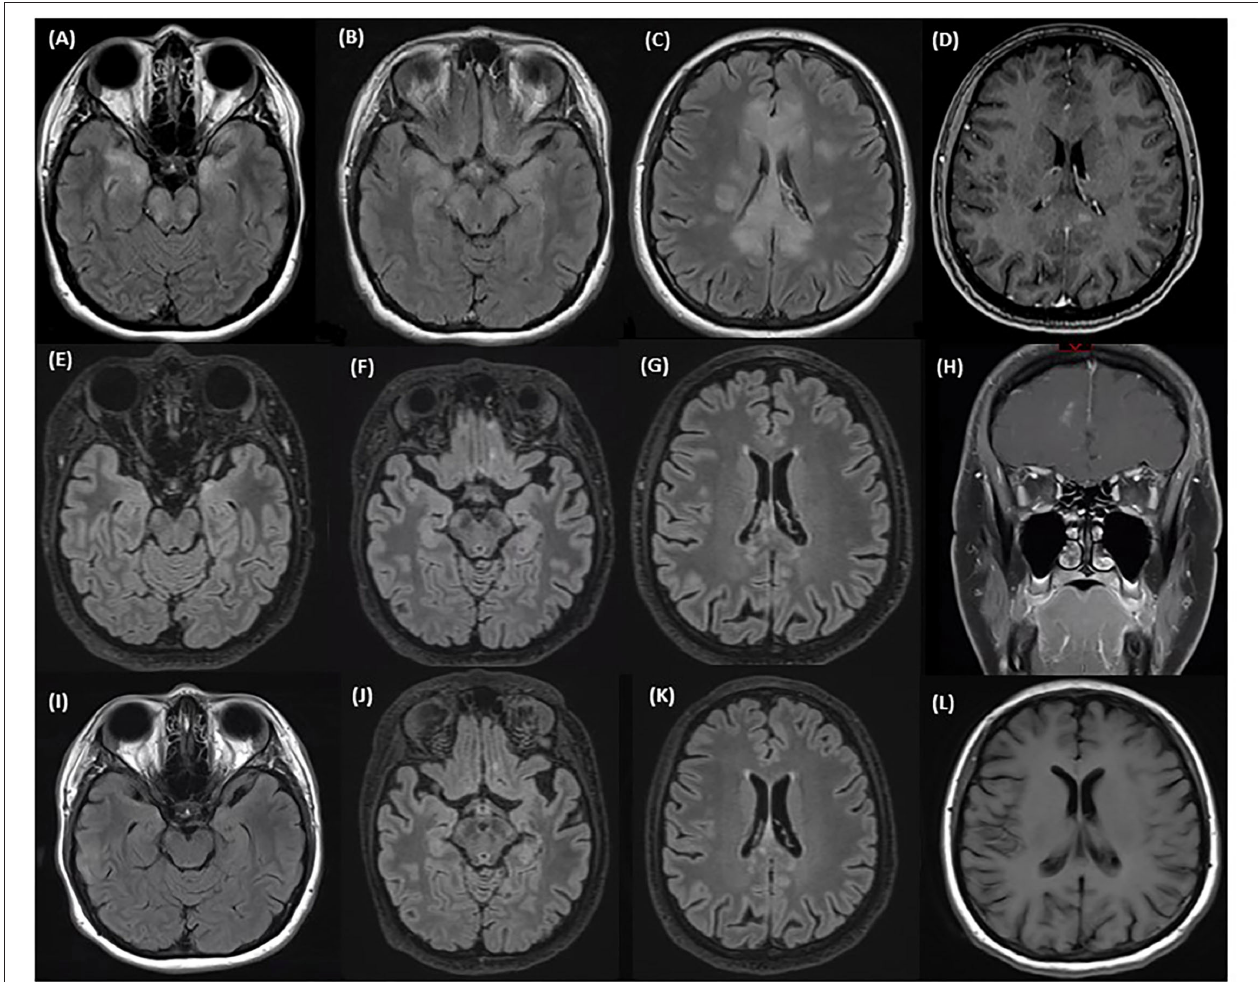
FIGURE 3 | MRI at time of first relapse: (A–C) Axial T2 FLAIR sequence of the brain showing involvement of the corpus callosum, bilateral mesial temporal lobes, bilateral inferior frontal lobes, and bilateral pons and midbrain. (D) Axial sequence of the brain with gadolinium showing discrete enhancing lesions in the corpus callosum. MRI after treatment of first relapse with corticosteroids and prior to eculizumab: (E–G) Axial T2 FLAIR sequences of the brain showing an improvement in the mesial temporal lobe and corpus callosum lesions after a course of steroids. (H) Coronal T1 sequences with gadolinium showing a new small right inferomedial frontal lesion with patchy enhancement. MRI after eculizumab: (I–K) Axial T2 FLAIR sequences of the brain showing stable inferior frontal and temporal lobe and corpus callosum lesions after starting eculizumab. (L) Axial T1 sequences with gadolinium showing no